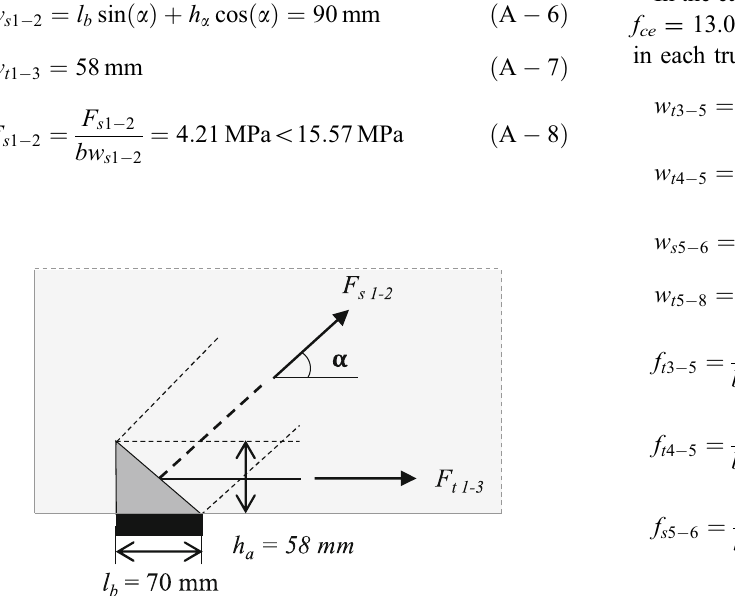
Fig. 9 Nodal zone 1 in specimen type